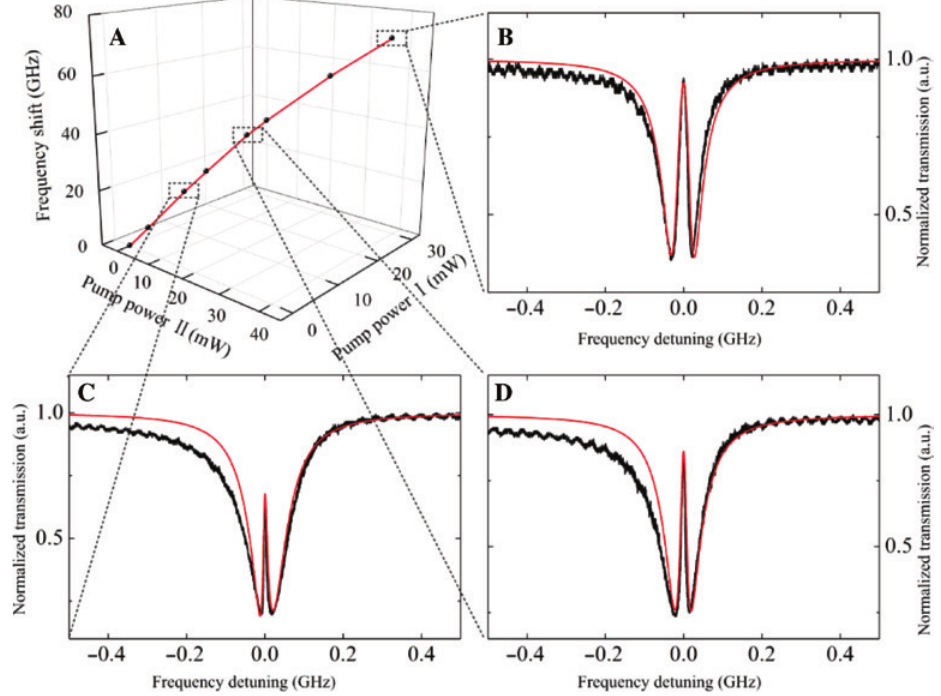
Figure 7: Tuning of the whole EIT spectrum. (A) Frequency shift of the whole EIT spectrum as a function of the pump power (pump power I in the lower- Q microcavity; pump power II in the higher- Q microcavity). (B–D) Three specific EIT spectra with different pump